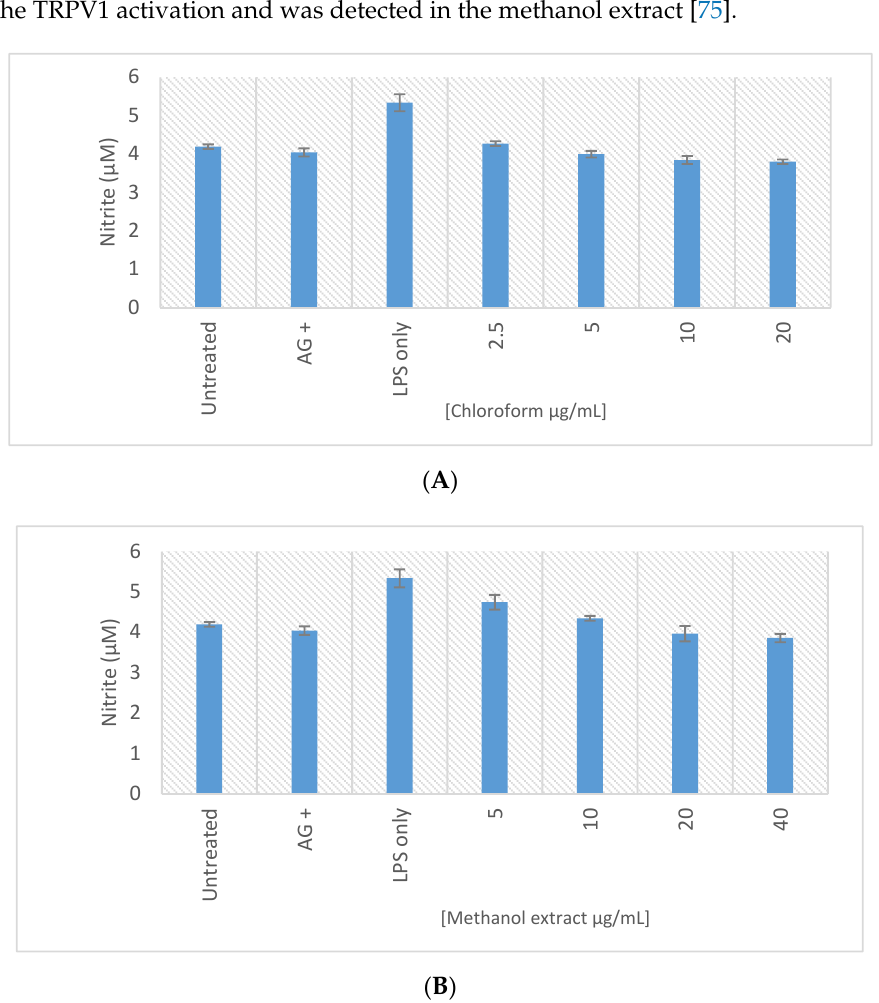
Figure 9. Nitric oxide production in the LPS activated macrophages treated with samples of the methanol extract ( A ) and chloroform extract ( B ). Bar graph represents the quadruplicate values of one experiment. Error bars represent the standard deviation of the mean.